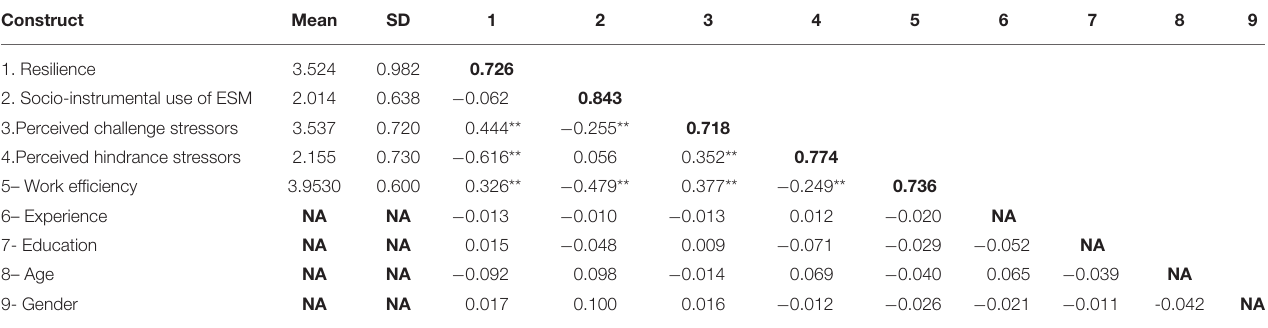
TABLE 3 | Correlation matrix and Mean, Standard